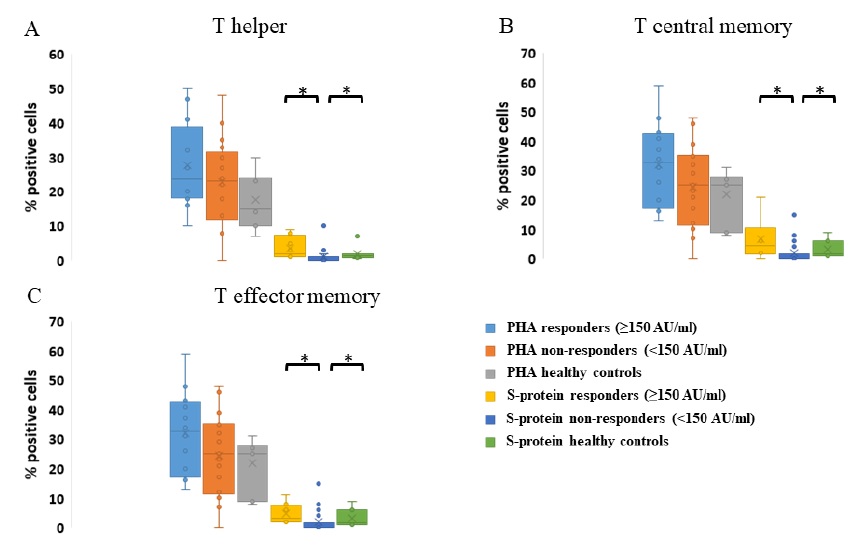
Figure 3. Cellular response. T-lymphocyte response to stimulation was evaluated by expression of the cellular activation markers CD134 and CD25 with flow cytometry. Samples were incubated for 48 h with PHA (positive control), no stimulation (negative control), or spike protein (test sample). Cellular response was evaluated in responding patients (antibody titers ≥ 150 AU/mL, n = 12), non-responding patients (antibody titers < 150 AU/mL, n = 18), and healthy controls (all had serological response to the vaccine, n = 7). ( A ) T-helper response to stimulation. ( B ) Central memory T-cell response to stimulation. ( C ) T-effector memory cell response to stimulation. There was no difference between the groups in response to PHA. Values are presented in Table S1. * p ≤ 0.001